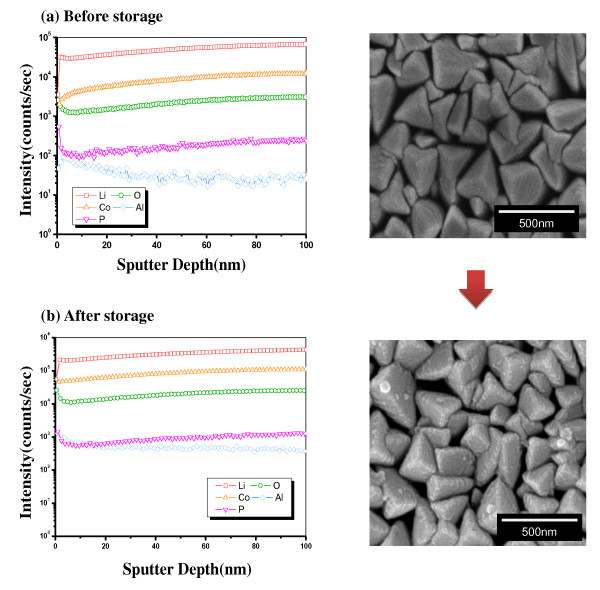
Depth profile of the constituent elements and SEM surface image of the AlPO4-coated LiCoO2 film. (a) Before storage; (b) after storage.